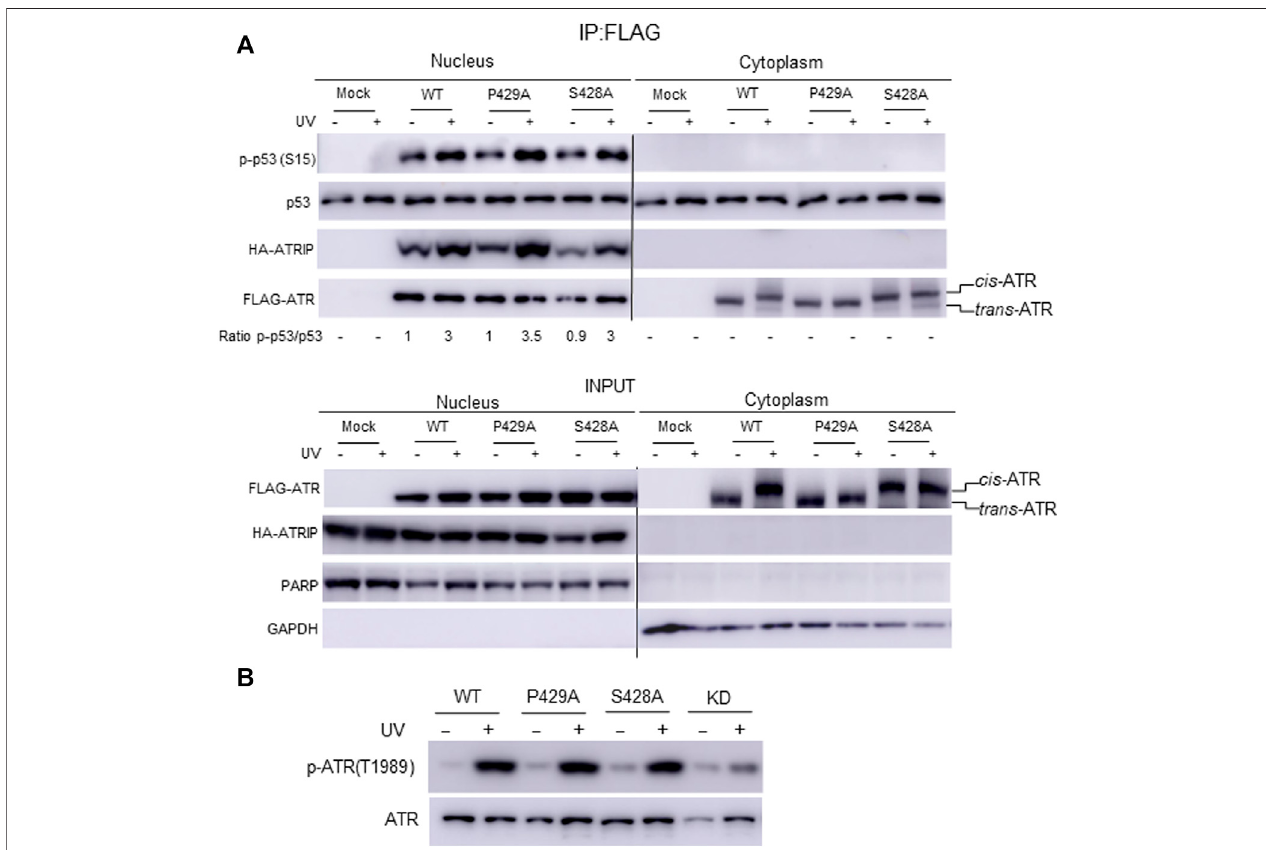
FIGURE 5 | Effectof cis/trans conformation of ATR on its kinase activity. (A) In vitro phosphorylation of puri fi ed GST-p53 was carried out to assess the checkpoint kinase activity of IPed ATR from the cytoplasmic and nuclear fractions of ATR fl ox/ − cells expressing co-transfected FLAG-ATR WT, mutants P429A, or S428A plus Myc- ATRIPconstructs.GST-p53phosphorylationwasmonitoredbyWesternblotusingphospho-S15p53antibody. (B) PhosphorylationofATRonT1989wasmonitoredto con fi rmthecheckpointkinaseactivityofATRWT,S428A,andP429AmutantproteinsinATR fl ox/ − cellsaftertransfectionwiththerespectiveplasmidconstruct.The nuclear fraction was collected from UV+/ − irradiated cells after 2 h of recovery.